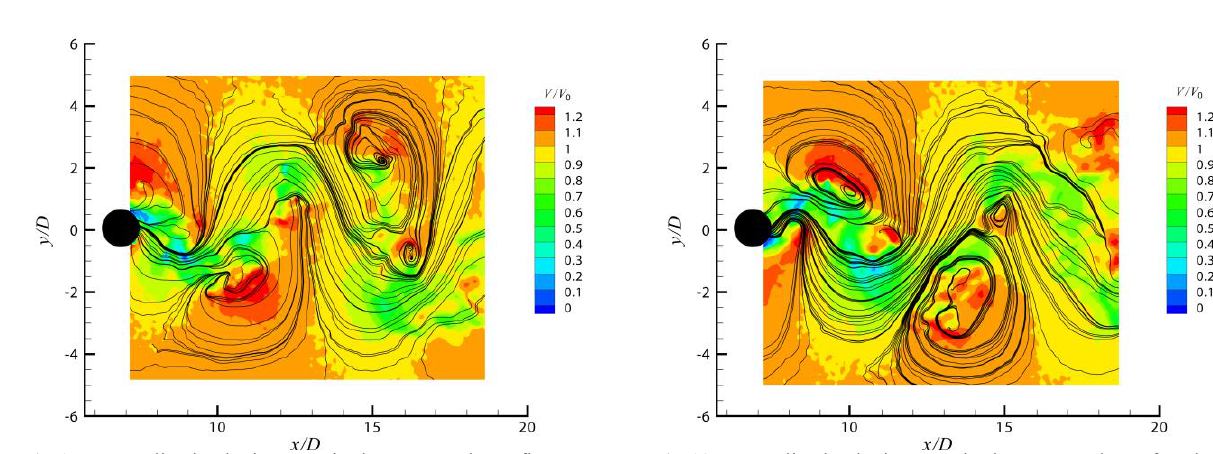
Fig.15 . Normalized velocity magnitude contour plot at first time step obtained for wake region